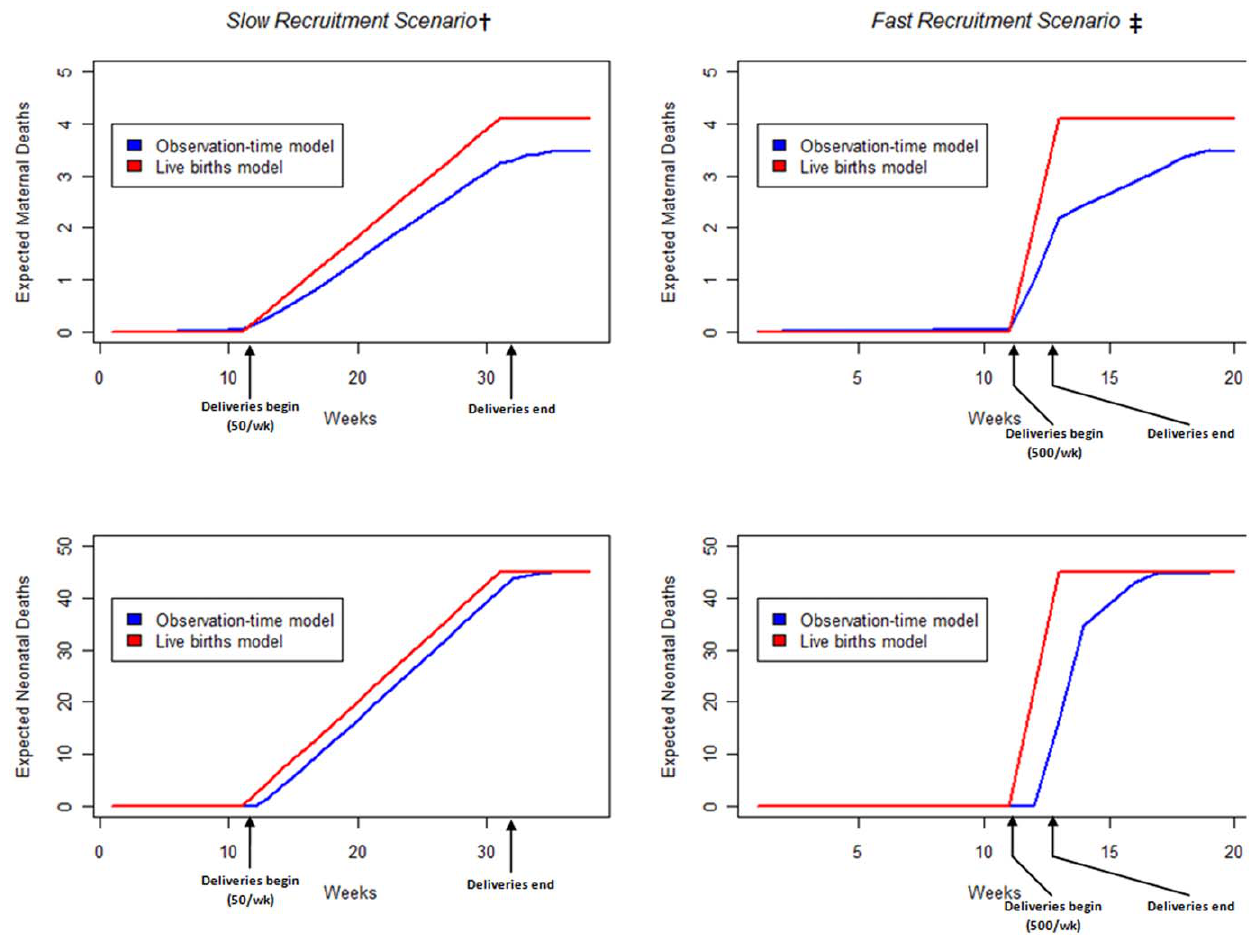
Figure 1. Observation-time model vs. Live births model to calculate expected background maternal and neonatal deaths over the course of a clinical trial in 1000 pregnant women in Mali. Assuming a maternal mortality ratio of 418.8 (327.5–519.8) per 100,000 live births, stillbirth rate of 23 (18–42) per 1,000 total births, early neonatal mortality rate of 33.5 (28.1–39.0) per 1,000 live births, and late neonatal mortality rate of 12.4 (9.9–15.5) per 1,000 live births estimated for Mali by recently published systematic analyses [3,44,45]. We assume women are recruited at 28 weeks gestation and deliver exactly 12 weeks later. { 50 pregnant women recruited each week over 20 weeks. { 500 pregnant women recruited each week over 2 weeks.